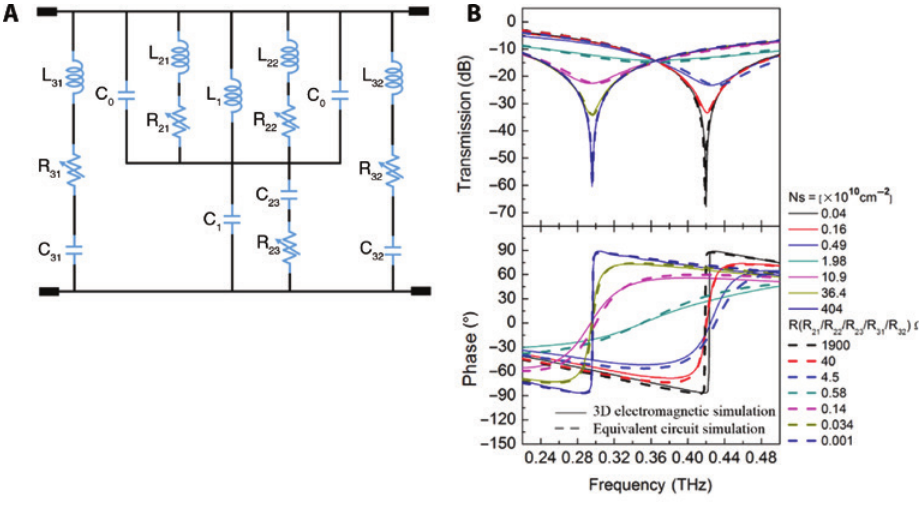
Figure 7: (A) Equivalent circuit model for LCDR and (B) 3D electromagnetic (continuous lines) and equivalent circuit (dashed lines) simulation for dynamic modulation